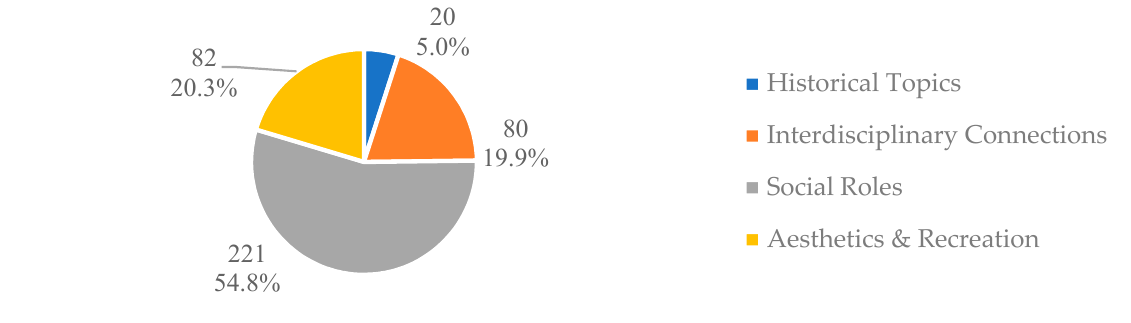
Figure 2. Pie chart of content distribution of mathematical culture.